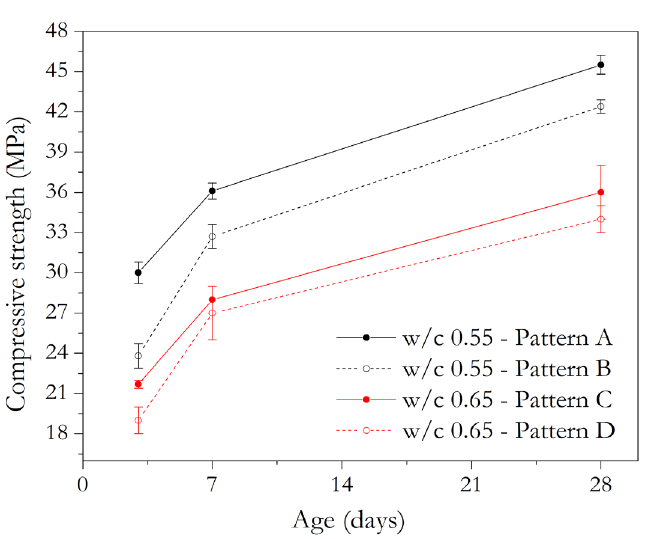
Figure 3. Average compressive strength.